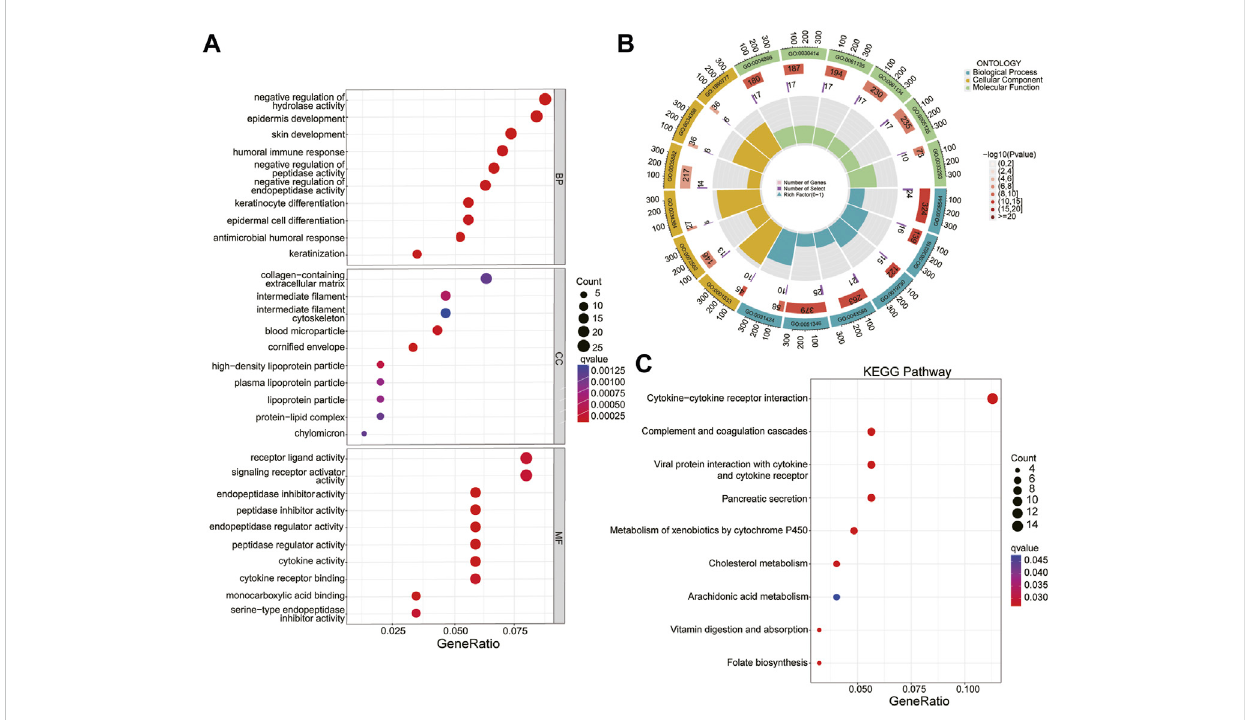
FIGURE 7 GO and KEGG analysis. (A, B) Biological process (BP), cellular component (CC), and molecular function (MF) of CRLs. (C) KEGG